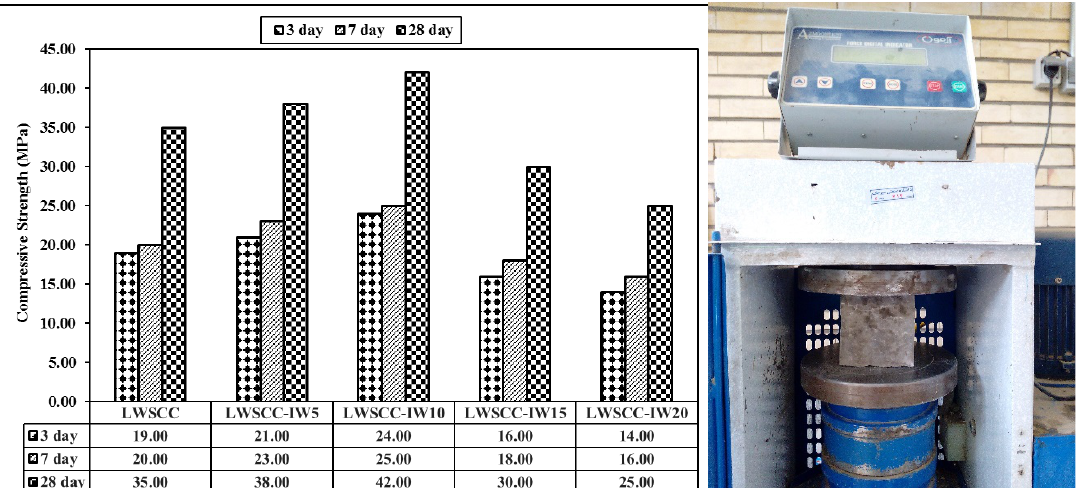
Figure 3 . Variation of compressive strengths of LWSCCs containing SMIW at different ages. Splitting tensile